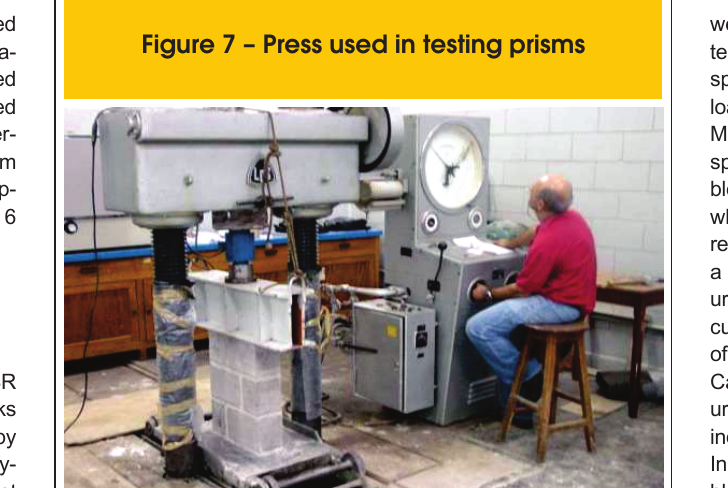
Figure 7 – Press used in testing